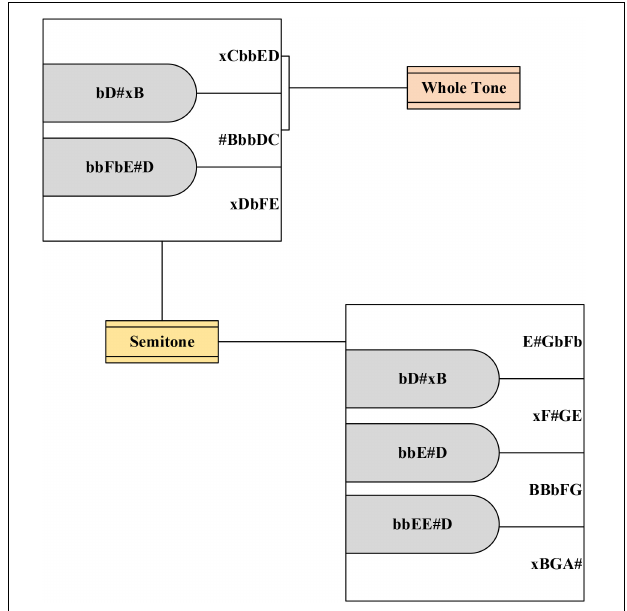
FIGURE 1 | Scale step arrangement method in